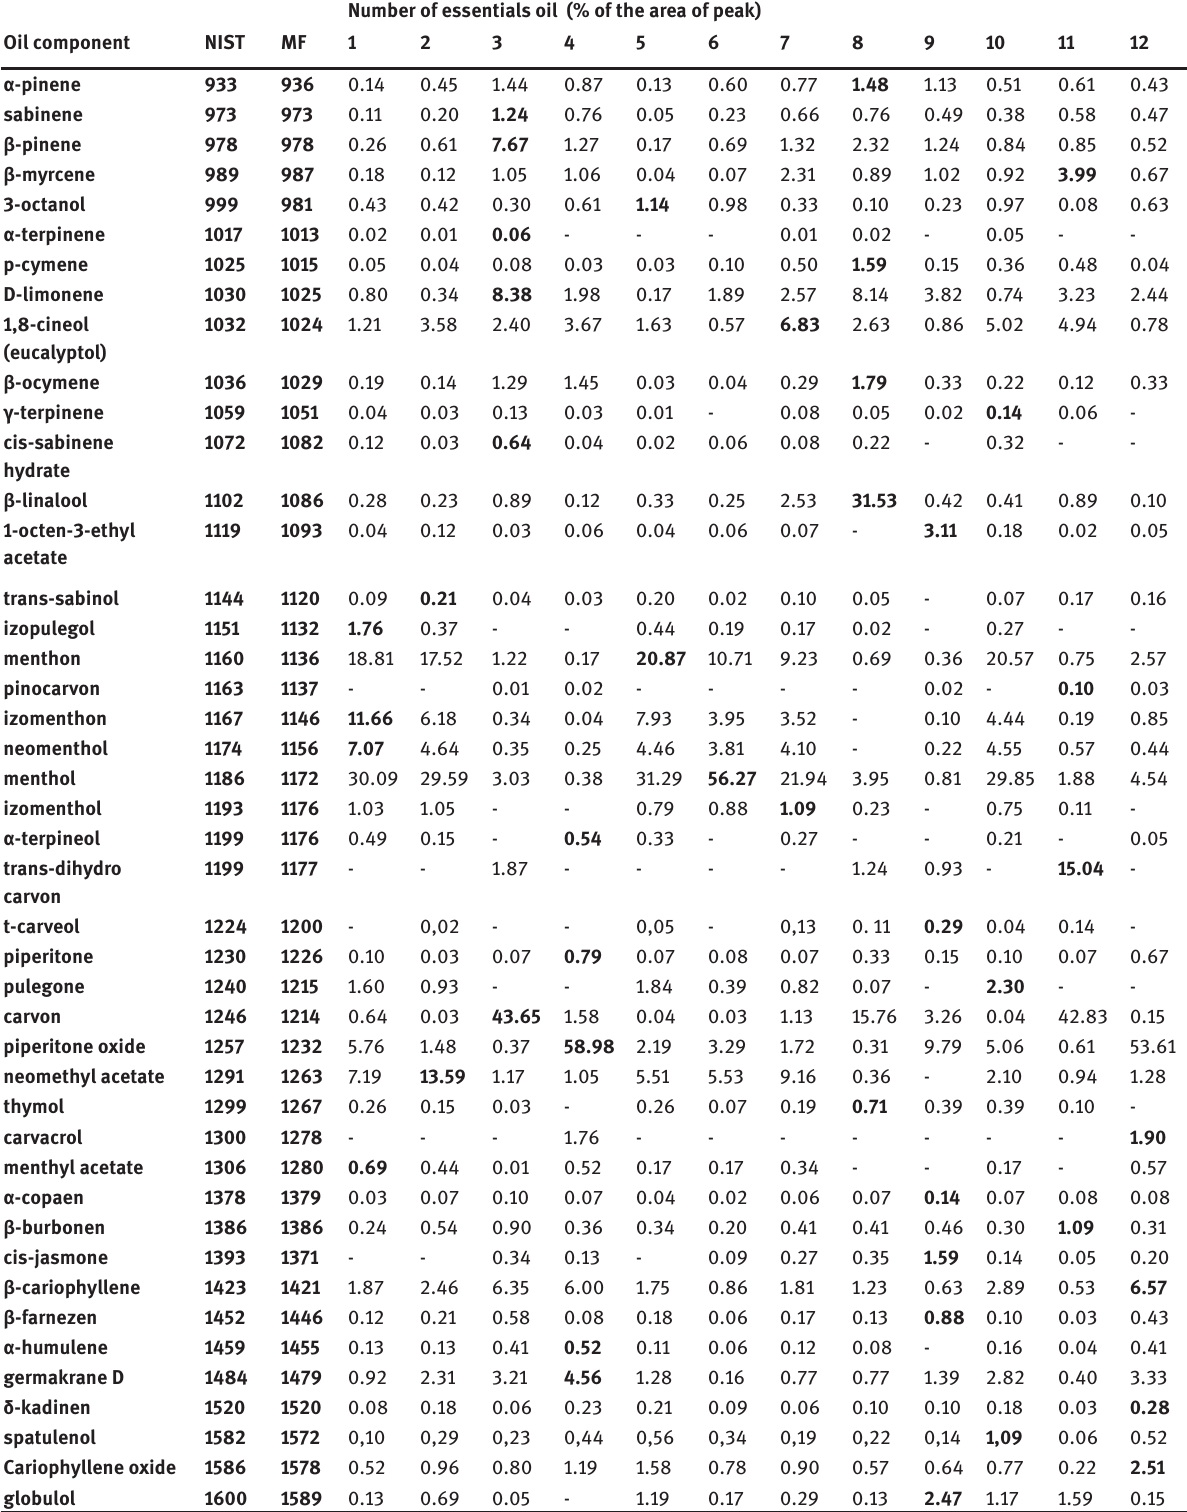
Table 2: The relative percentage of the area of peak of essentials oils constituents. Numbers as in Table 1. Number of essentials oil (% of the area of